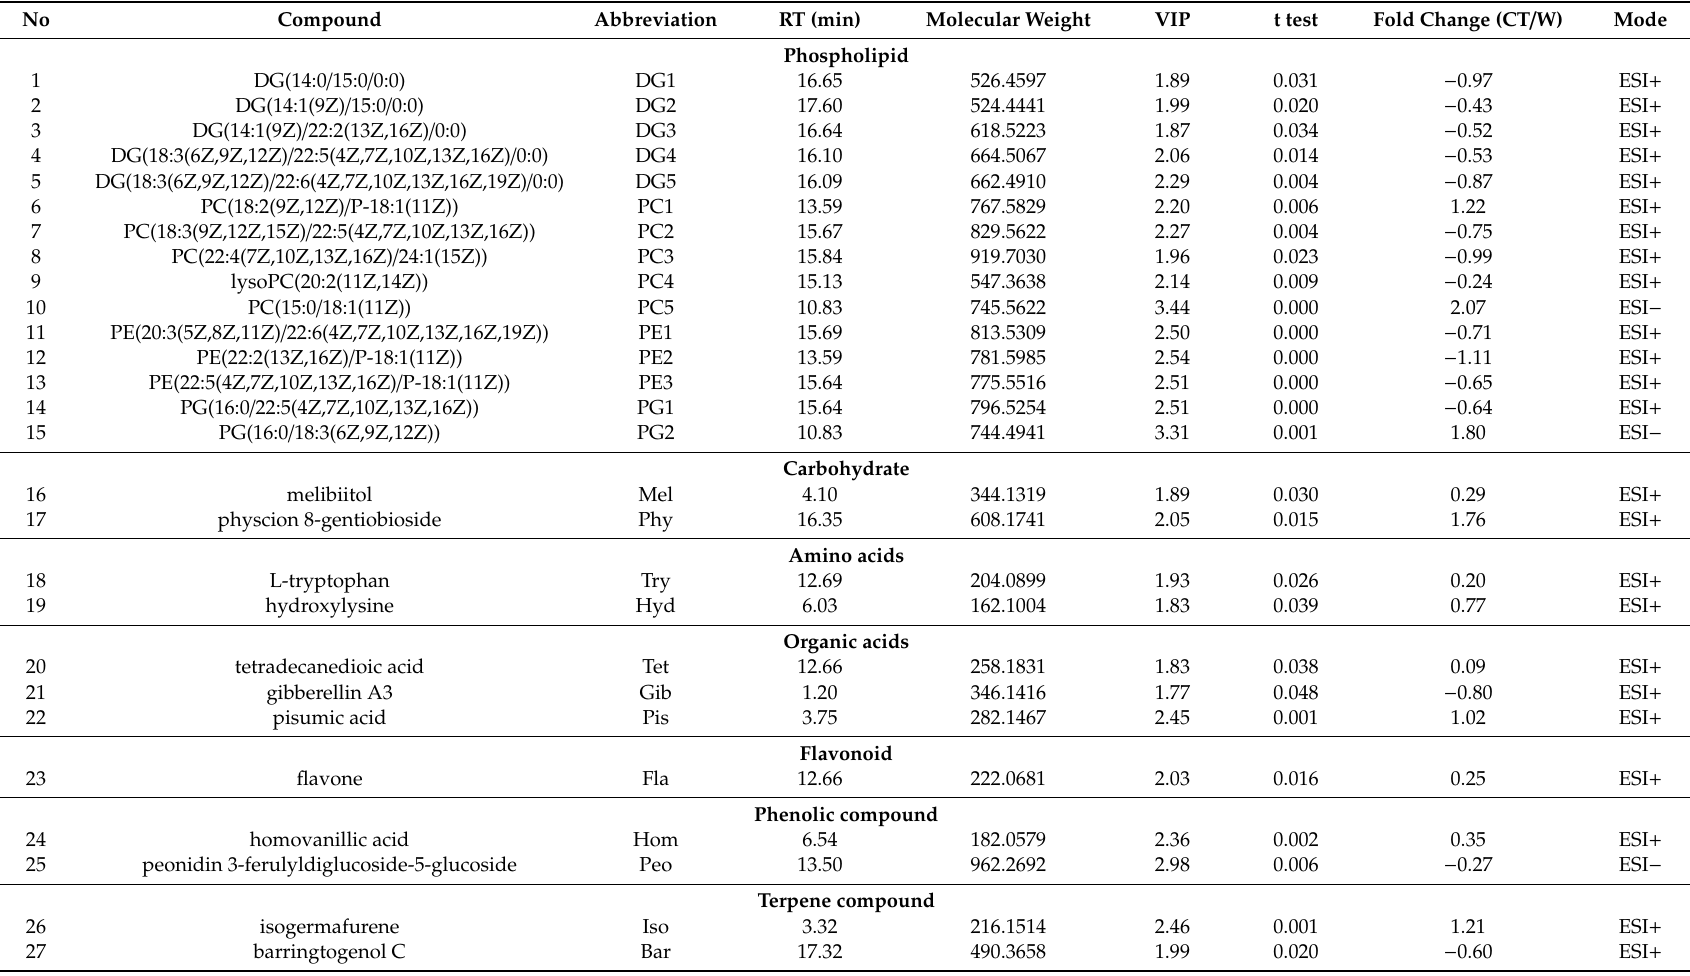
Table 3. Extractable plant metabolites identified in the leaf of Cunninghamia lanceolata under the control (CT) and warming (W) treatments, broadly classified into